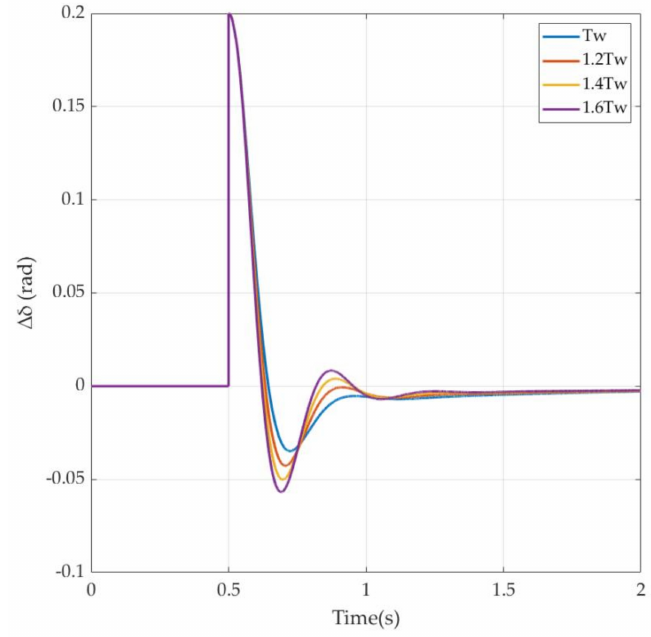
Figure 23. The control effect of the controller when T w changes ( ∆ δ − t )